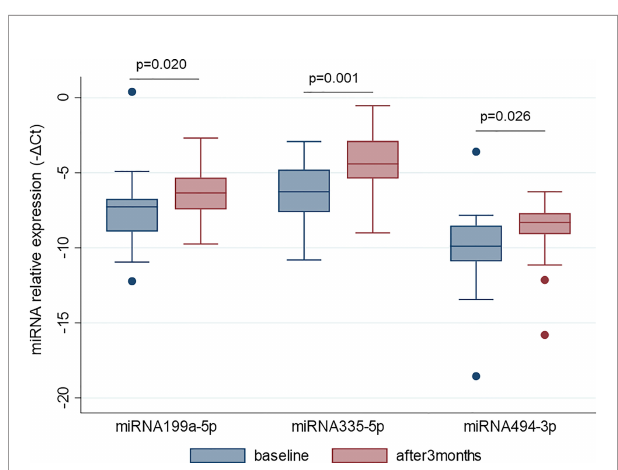
FIGURE 4 | MiR-199a-5p, miR-335-5p and miR-494-3p are upregulated after 3 months of GH treatment with respect to the baseline. MiRNA levels are expressed as – D Ct where D Ct is calculated as: Ct miRNA − Ct miR-16- 5p. p -value ≤ 0.05 at paired Student ’ s t -test.